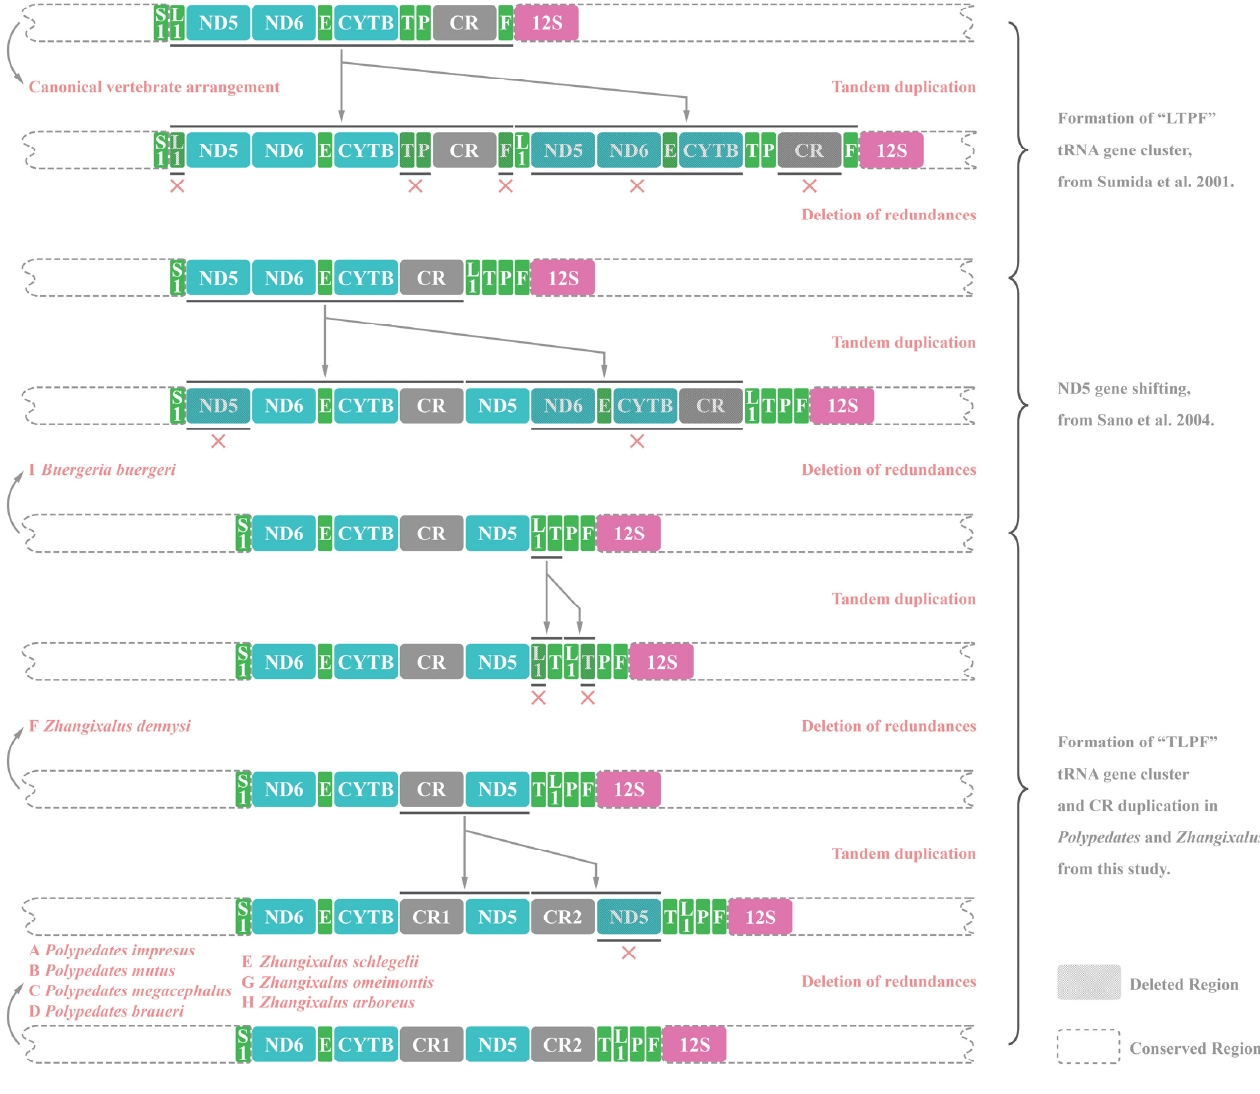
Figure 7. Diagram of the presumptive gene rearrangement pathway with tandem duplication and random loss (TDRL) processes. Step formation of “LTPF” tRNA gene cluster from Sumida et al. [62]. Step ND5 gene shifting from Sano et al. [36]. The length of features was not drawn to match their actual nucleotide proportion in the